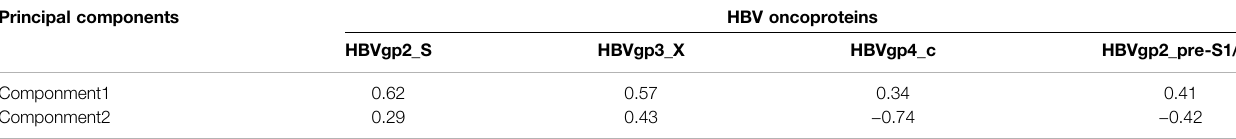
TABLE 1 | Coef fi cients of four HBV oncoproteins to the fi rst and second principal components. Principal